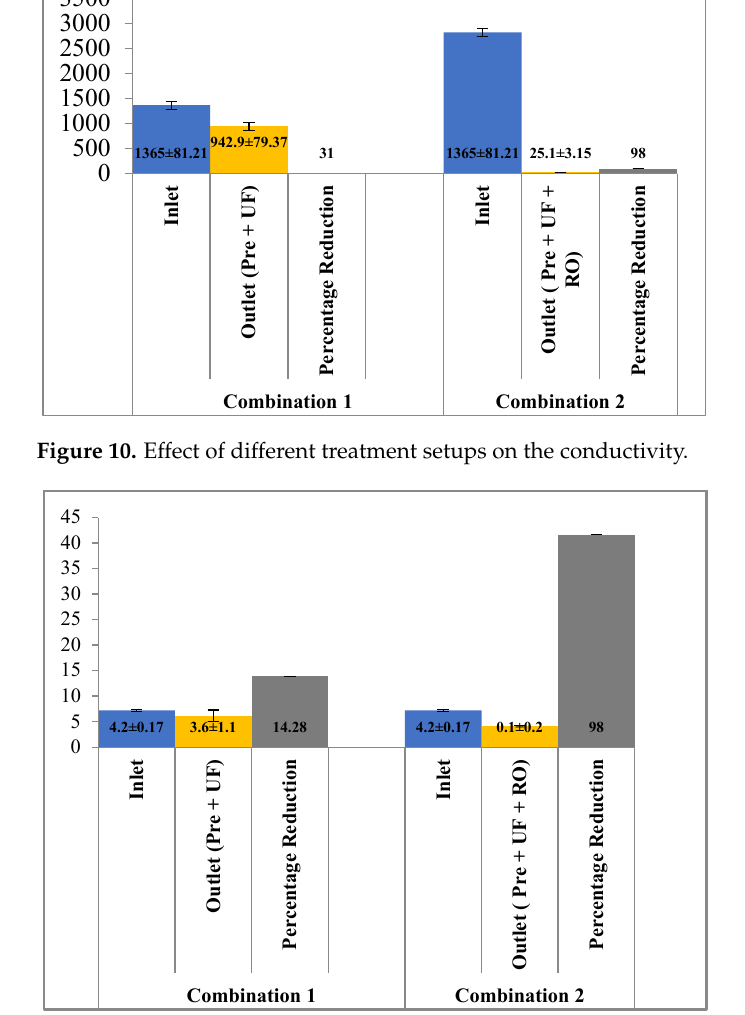
Figure 11 . Effect of different treatment setups on removal of potassium .